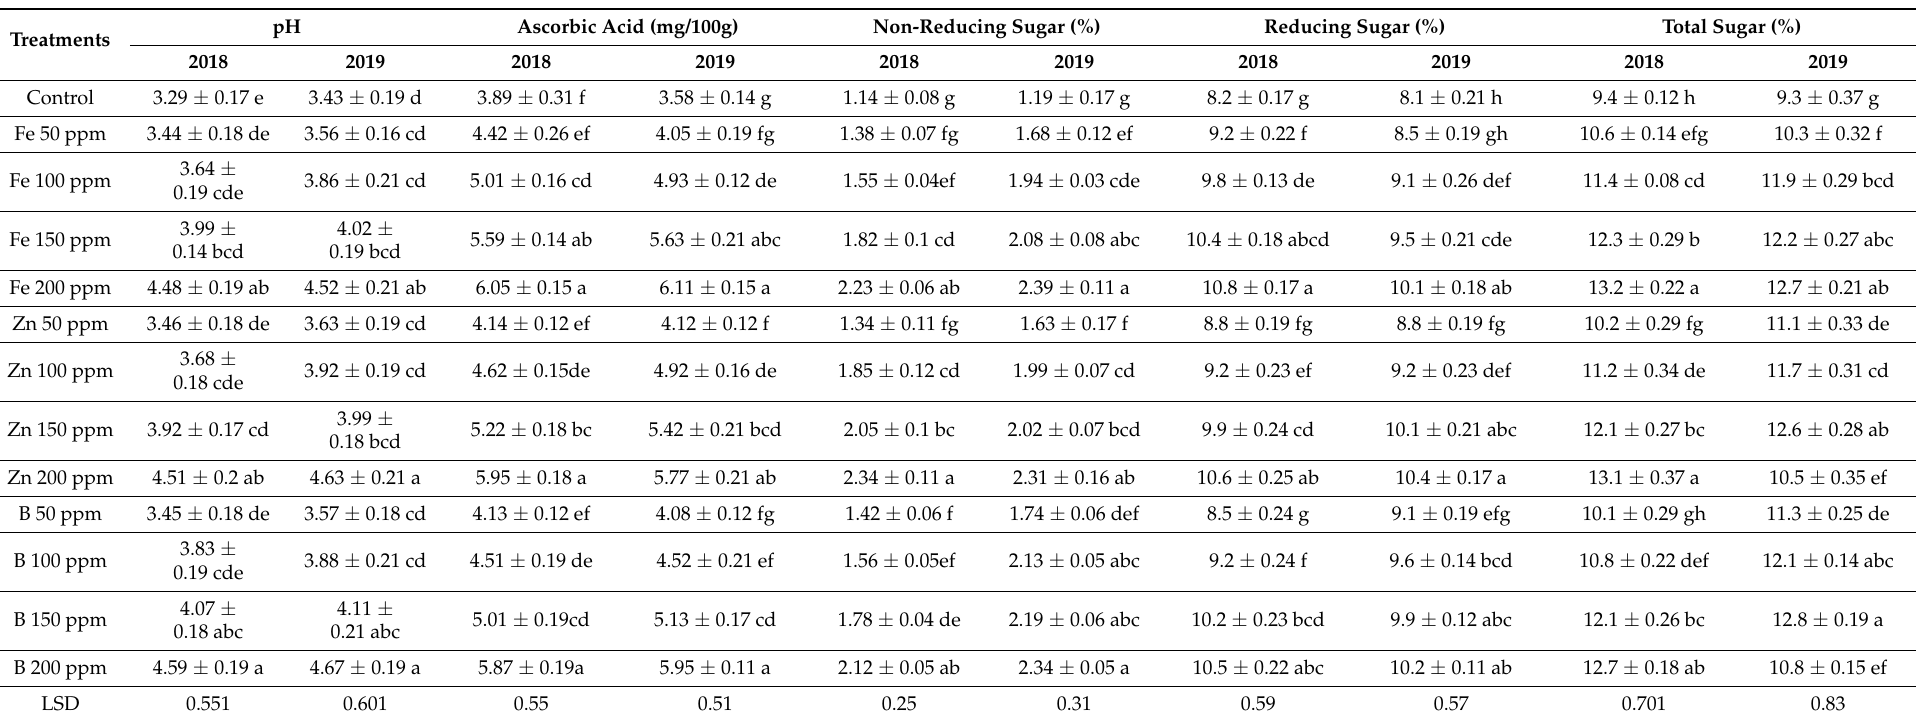
Table 4. Effect of foliar application of micronutrients on different quality characteristics of grapes cv. ‘Flame Seedless’ during the years 2018 and 2019. pH Ascorbic Acid (mg/100g) Non-Reducing Sugar (%) Reducing Sugar Treatments